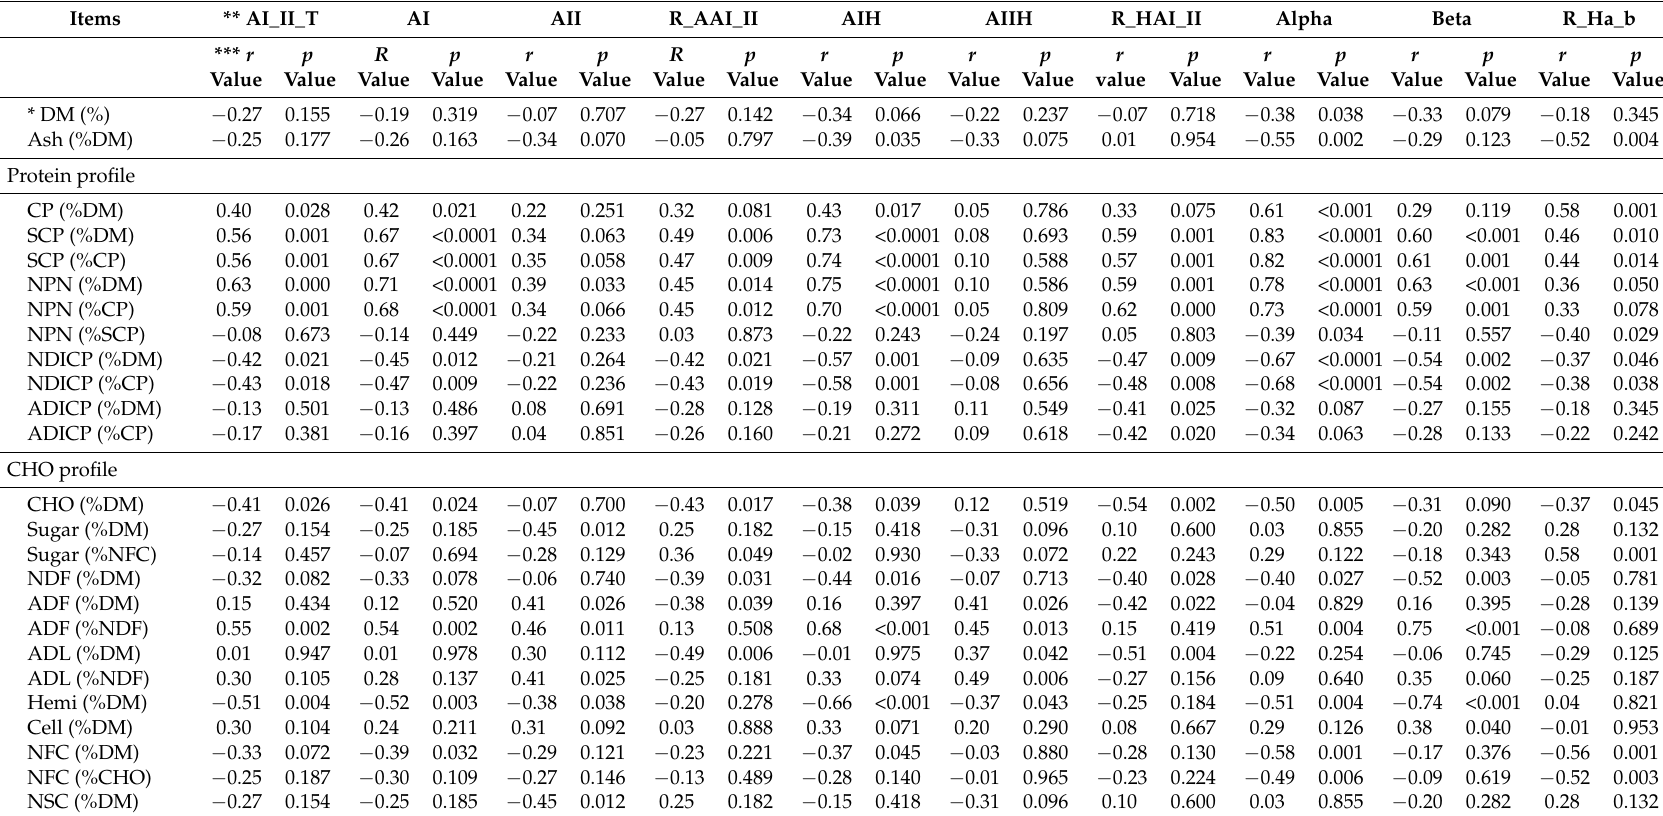
Table 8. Correlation analyses between protein structure spectral characteristics and chemical profile of canola